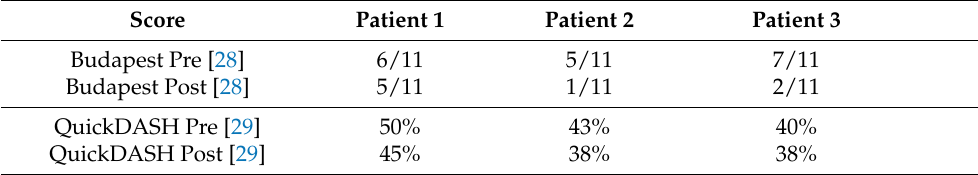
Table 3. Overview of patient follow-up according to QuickDASH and the Budapest score over a follow-up period of six weeks. In each case, a lower score corresponds to a better patient